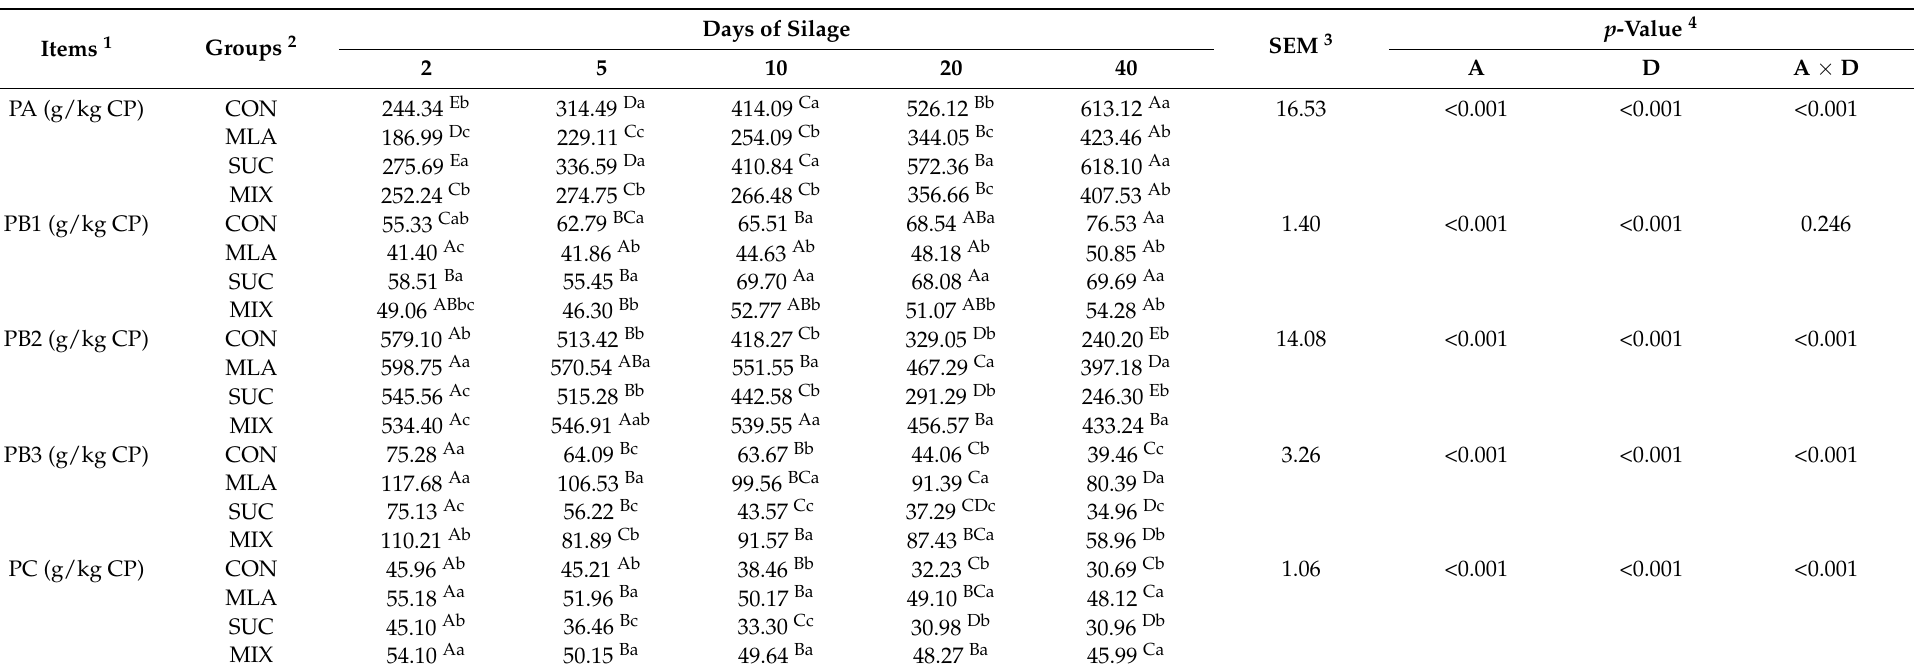
Table 4. CNCPS nitrogen fractions of ensiled Moringa oleifera leaves treated with malic acid and